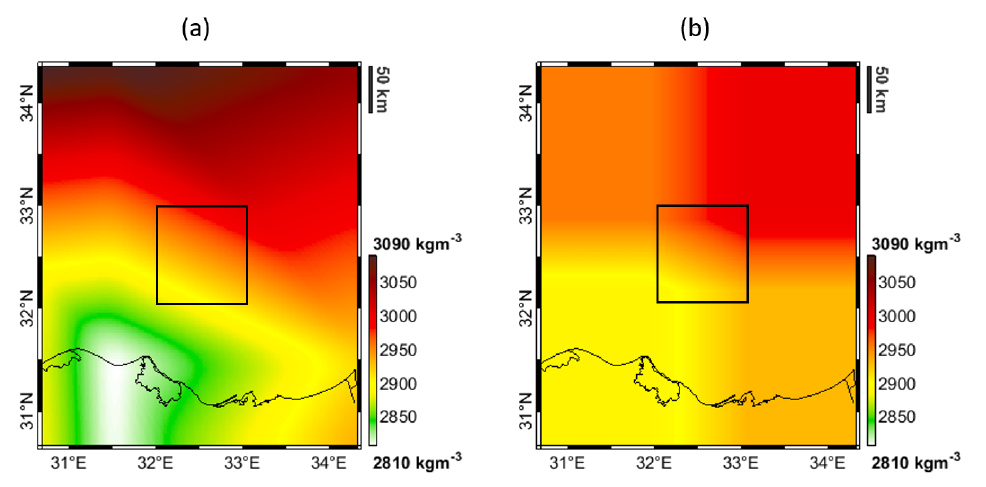
Figure 5. Density model at a depth of 22 km from the CRUST1.0 model ( a ), and density model extrapolated by the nearest neighbor algorithm ( b ). The black rectangles at the center of each map represent the study